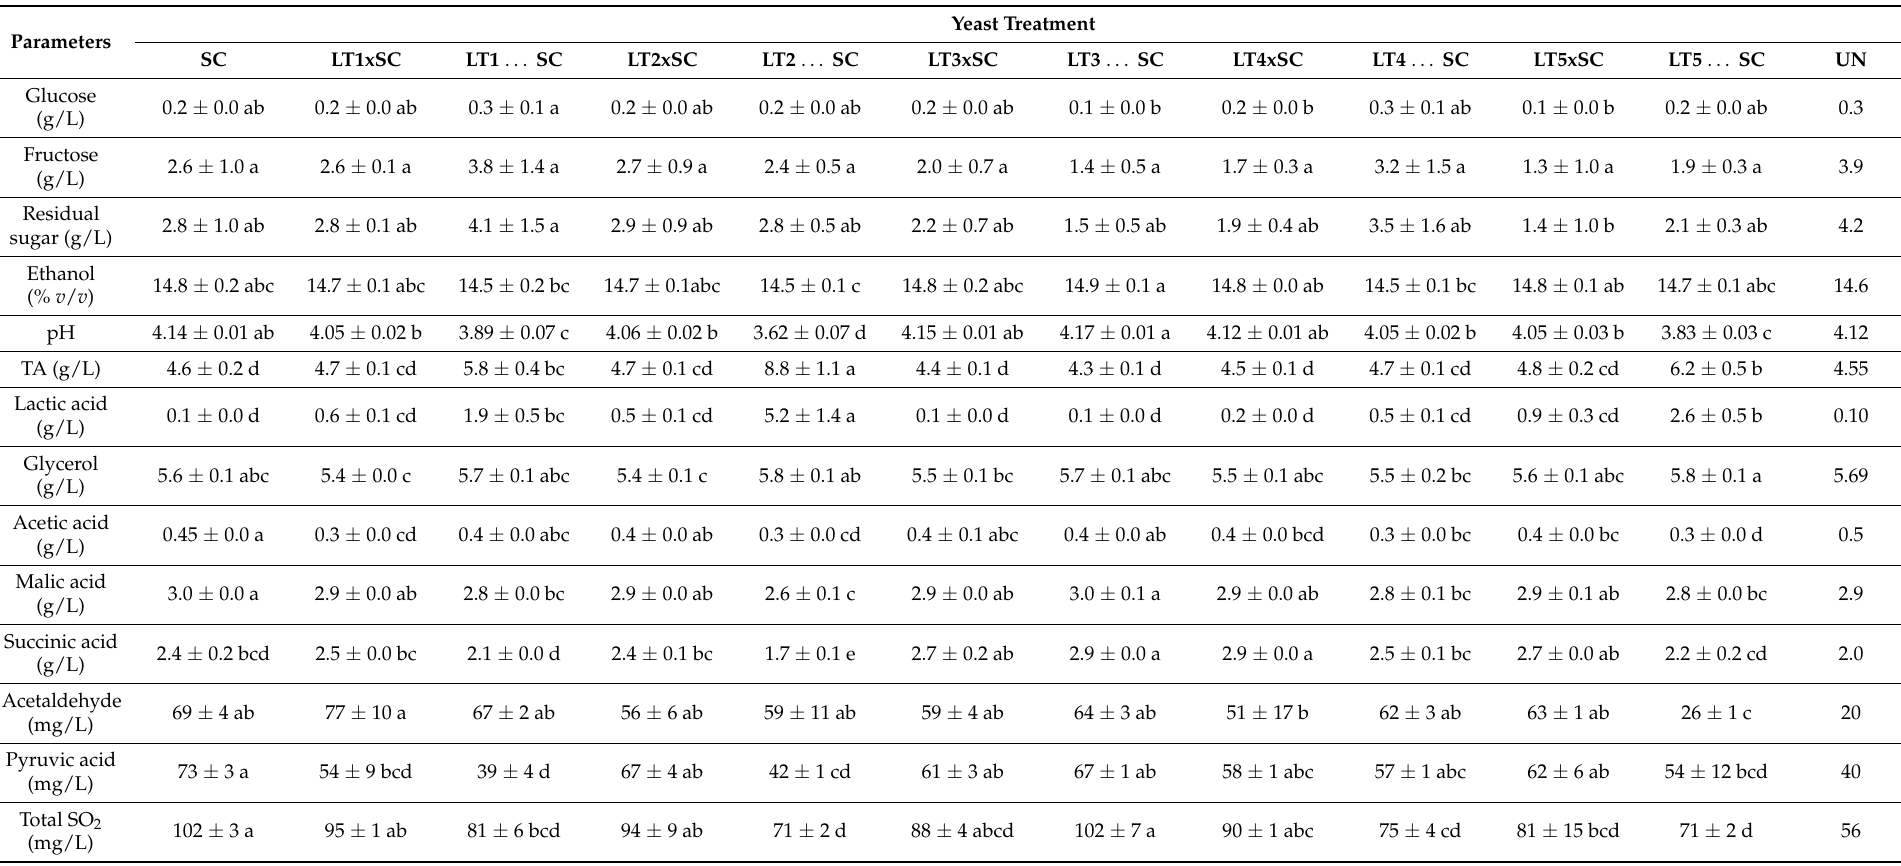
Table 1. Main oenological parameters of Viognier wines fermented with 12 yeast treatments. Values are the mean of winemaking triplicates and standard errors, and letters within the same row denote significance groups (ANOVA; Tukey’s post-hoc α = 5%). The yeast treatments include the Saccharomyces cerevisiae monoculture (SC), five Lachancea thermotolerans strains (LT1-LT5) in co-inoculations (xSC) or sequential inoculations ( . . . SC) with S. cerevisiae , and an un-inoculated treatment (UN). The un-replicated treatment UN was excluded from the statistical